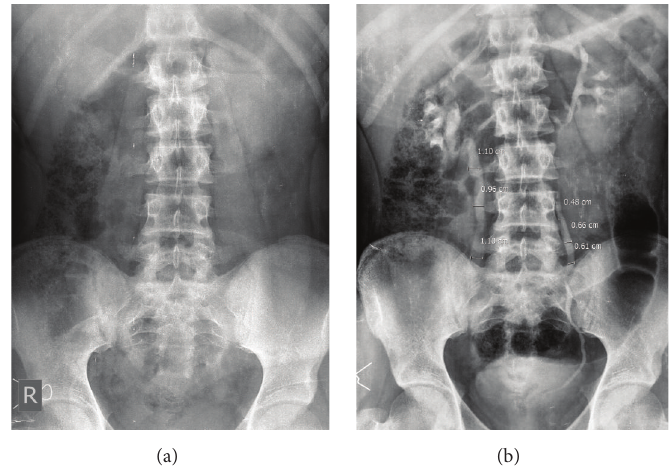
Figure 2: (a) Scout film: male patient with right-sided flank pain. No radiopaque calculus seen. (b) IVU: right ureter was dilated, but the cause was not obvious. No vesicoureteral reflux seen on color Doppler. Urine examination revealed tuberculosis.